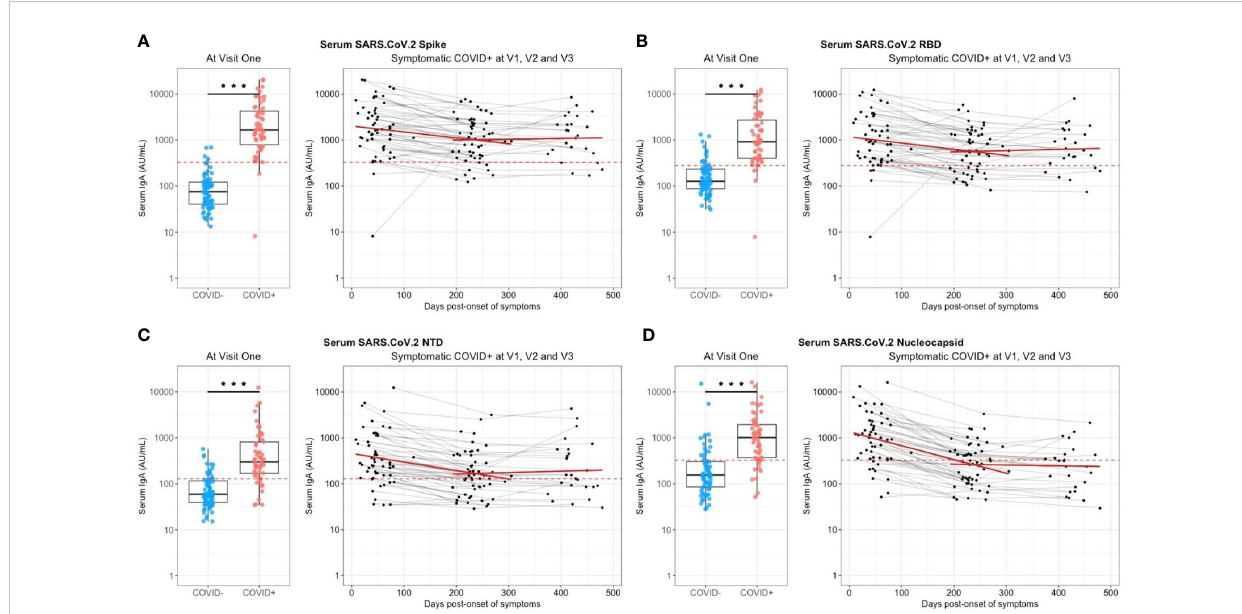
FIGURE 1 Serum anti-SARS-CoV-2 IgA kinetics and speci fi city up to 16 months after COVID-19 acute infection and without immunization. Serum anti-SARS-CoV2 IgA (UA/ml) were quanti fi ed on a MesoQuickPlex SQ120 using the V-PLEX COVID-19 Coronavirus Panel 2 IgA kit, from naive (COVID-, blue) and previously infected (COVID+, red) individuals at enrollment (V1, boxplots on the left), and its kinetic of decrease (mean slope in red) for symptomatic COVID-19+ individuals up to 16 months after the acute infection (timeline evolution of the signal on the right). (A) Serology IgA titers against the whole Spike. (B) Serology IgA titers against the Spike/RBD. (C) Serology IgA titers against the Spike/NTD. (D) Serology IgA titers against the Nucleocapsid. The red dashed line corresponded to the positivity threshold, determined by the quantitative variable maximizing both sensitivity and speci fi city (i.e.